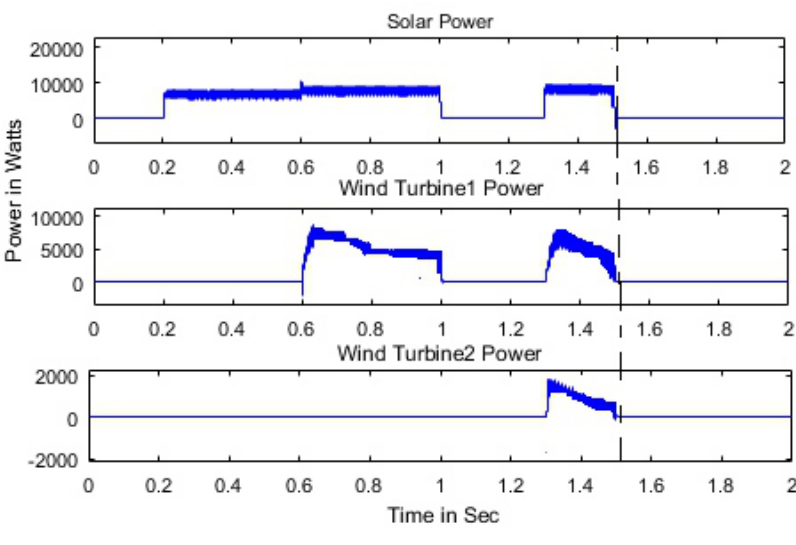
Figure 19. Power from Solar, WT1, WT2 in AC